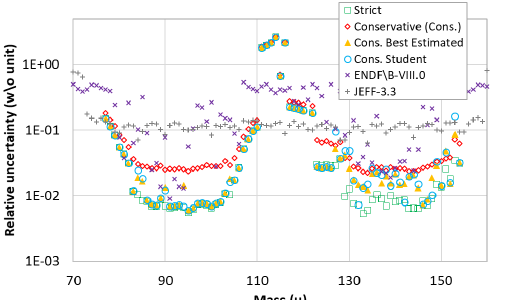
Fig. 15. Relative uncertainties of the different solutions as a function of mass in comparison to current evaluations.